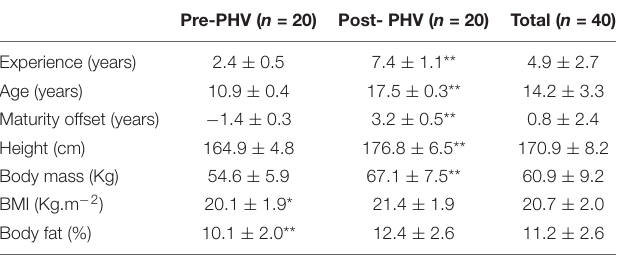
TABLE 1 | Participants’ anthropometric characteristics by player’s maturity status.